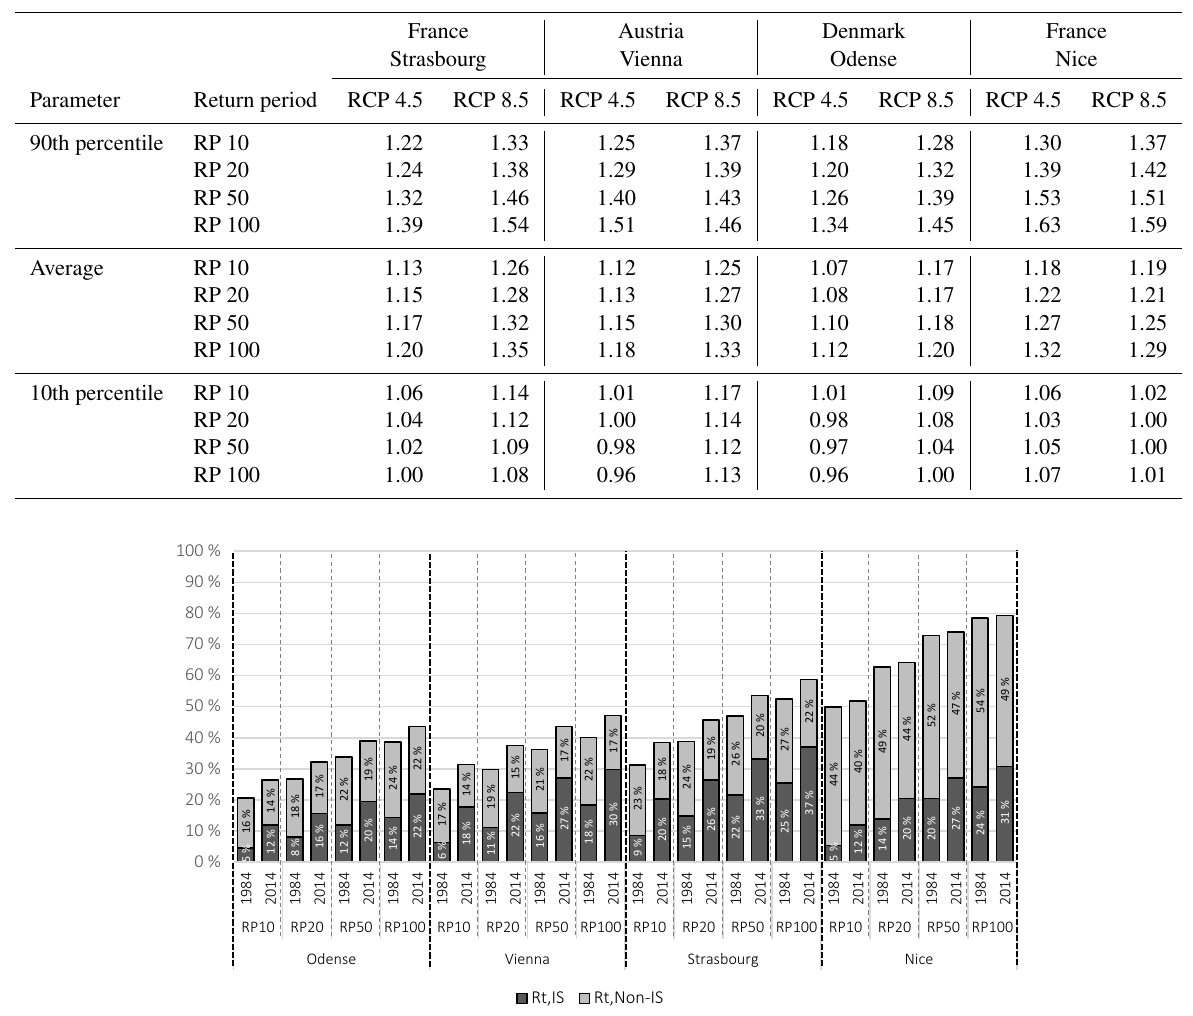
Table 2. Change factors for hourly precipitation for the period 2081–2100 (control period: 1986–2005) for RCP 4.5 and RCP 8.5 for Strasbourg, Vienna, Odense and Nice. Results are based on regional climate projections using the RCA4 regional climate model, downscaling 10 different GCMs: CANESM2, CSIRO, CERFACS, ICHEC, IPSL, MIROC, MOHC, MPI, NCC and NOAA (ESGF, 2016).